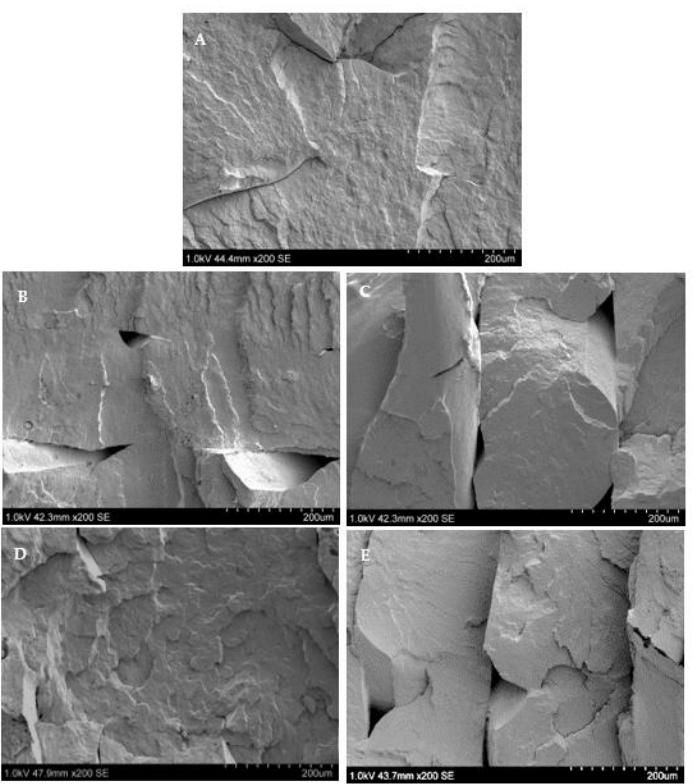
Figure 12. SEM micrographs of Charpy impact 3D printed test specimen fractured surfaces at − 38 ◦ C: ( A ) Denotes PHB (55%)/PLA (45%); ( B ) Denotes PHB (55%)/PLA (4 5%) + 2 wt.% CC; ( C ) Denotes PHB (55%)/PLA (45%) + 4 wt.% CC; ( D ) Denotes PHB (55%)/PLA (45%) + 6 wt.% CC; ( E ) Denotes PHB (55%)/PLA (45%) + 8 wt.%